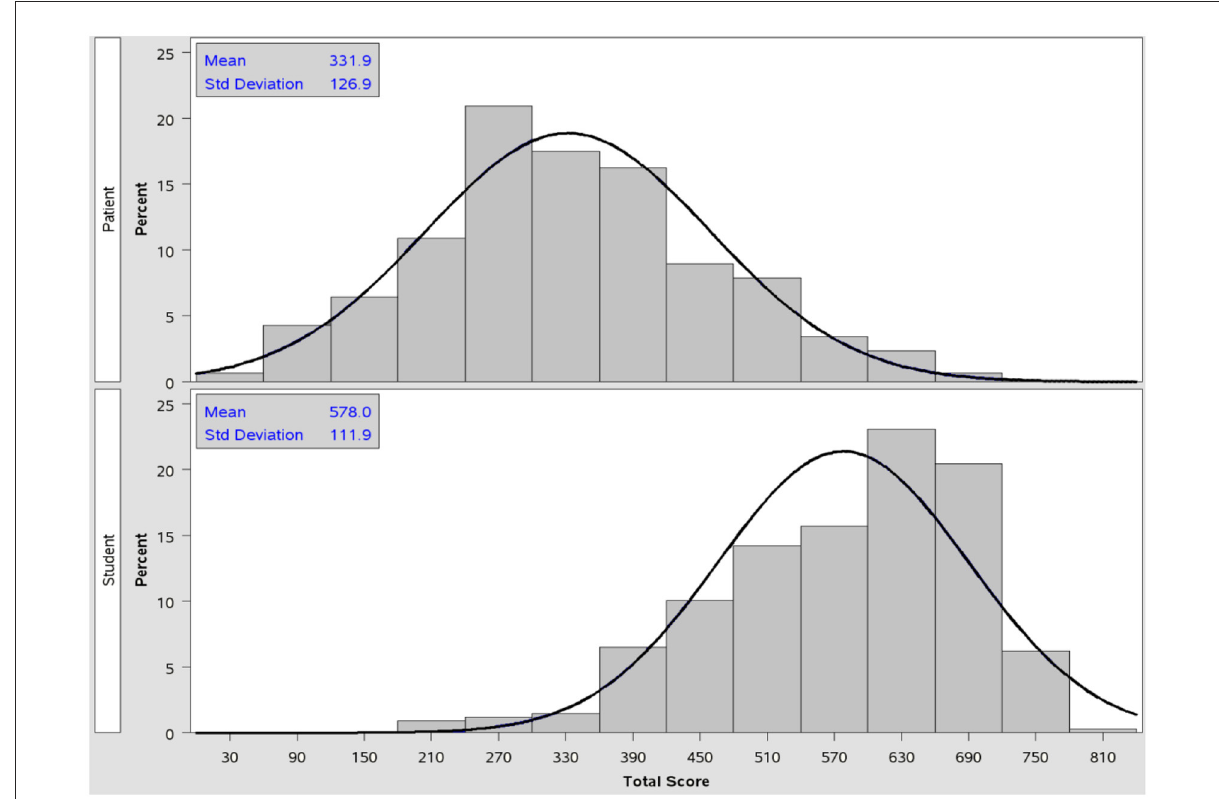
FIGURE4 Comparison of the distributions of the SF-36 total score - patient group (upper picture) and student group (lower picture). Maximum possible total score is 800 (the best perception of each item in the questionnaire). Normality test results (Shapiro-Wilk test): group of patients (W = 0.9934; p = 0.0385), group of students (W = 0.9588; p <